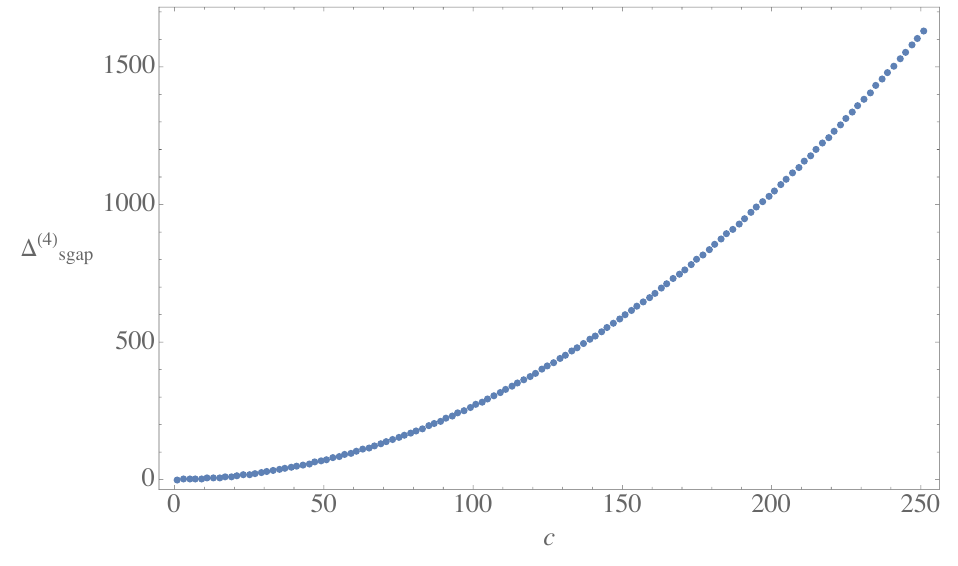
Figure 2 . Plot of a bound on the scalar gap for U(1) c CFTs with 4 derivatives, up to central charge c = 251 . The numerical data seems to be well-approximated by a quadratic function with leading coefficient 1 (see 4 π 2